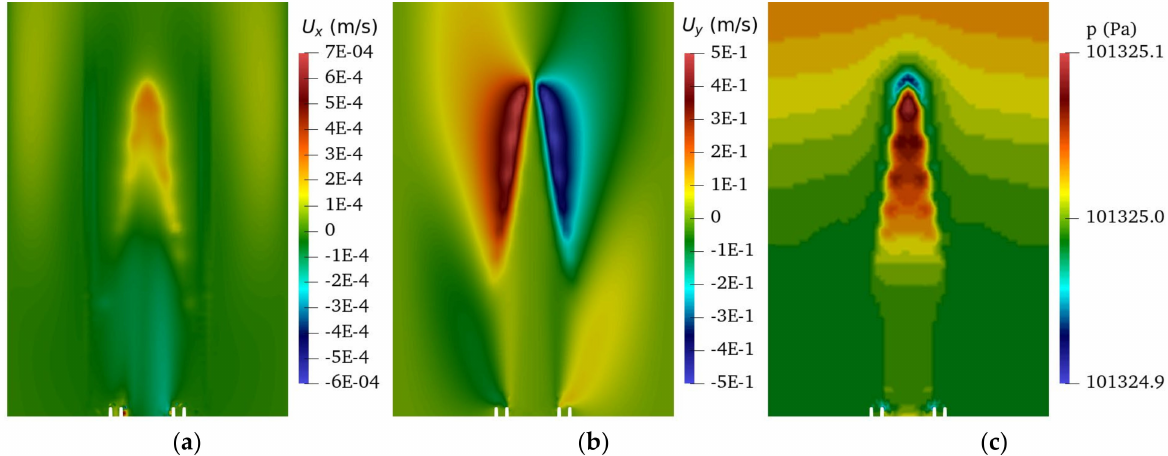
Figure 8. The y–z plane cut of the URANS simulation for ( a ) x-component velocity, ( b ) y-component velocity, and ( c ) pressure.